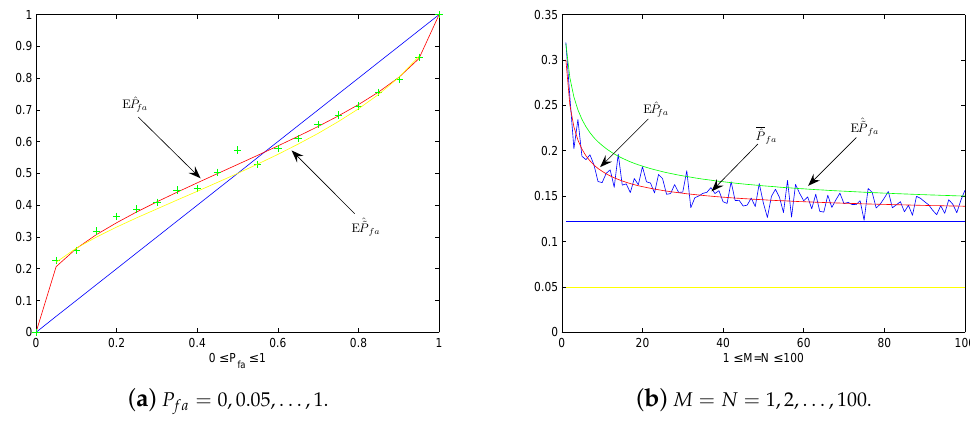
Figure 3. The plot of ˆ P fa by ’+’, E ˆ P fa and E ˆ˜ P fa under setting of P fa = 0,0.05, . . . ,1 and M = N = 1,2, . . . ,100. ( a ) The plot of ˆ P fa by ’+’, E ˆ P fa and E ˆ˜ P fa vs P fa = 0,0.05, . . . ,1. ( b ) The plot of ˆ P fa , E ˆ P fa and E ˆ˜ P fa vs. M = N = 1,2, . . . ,100, under P fa =